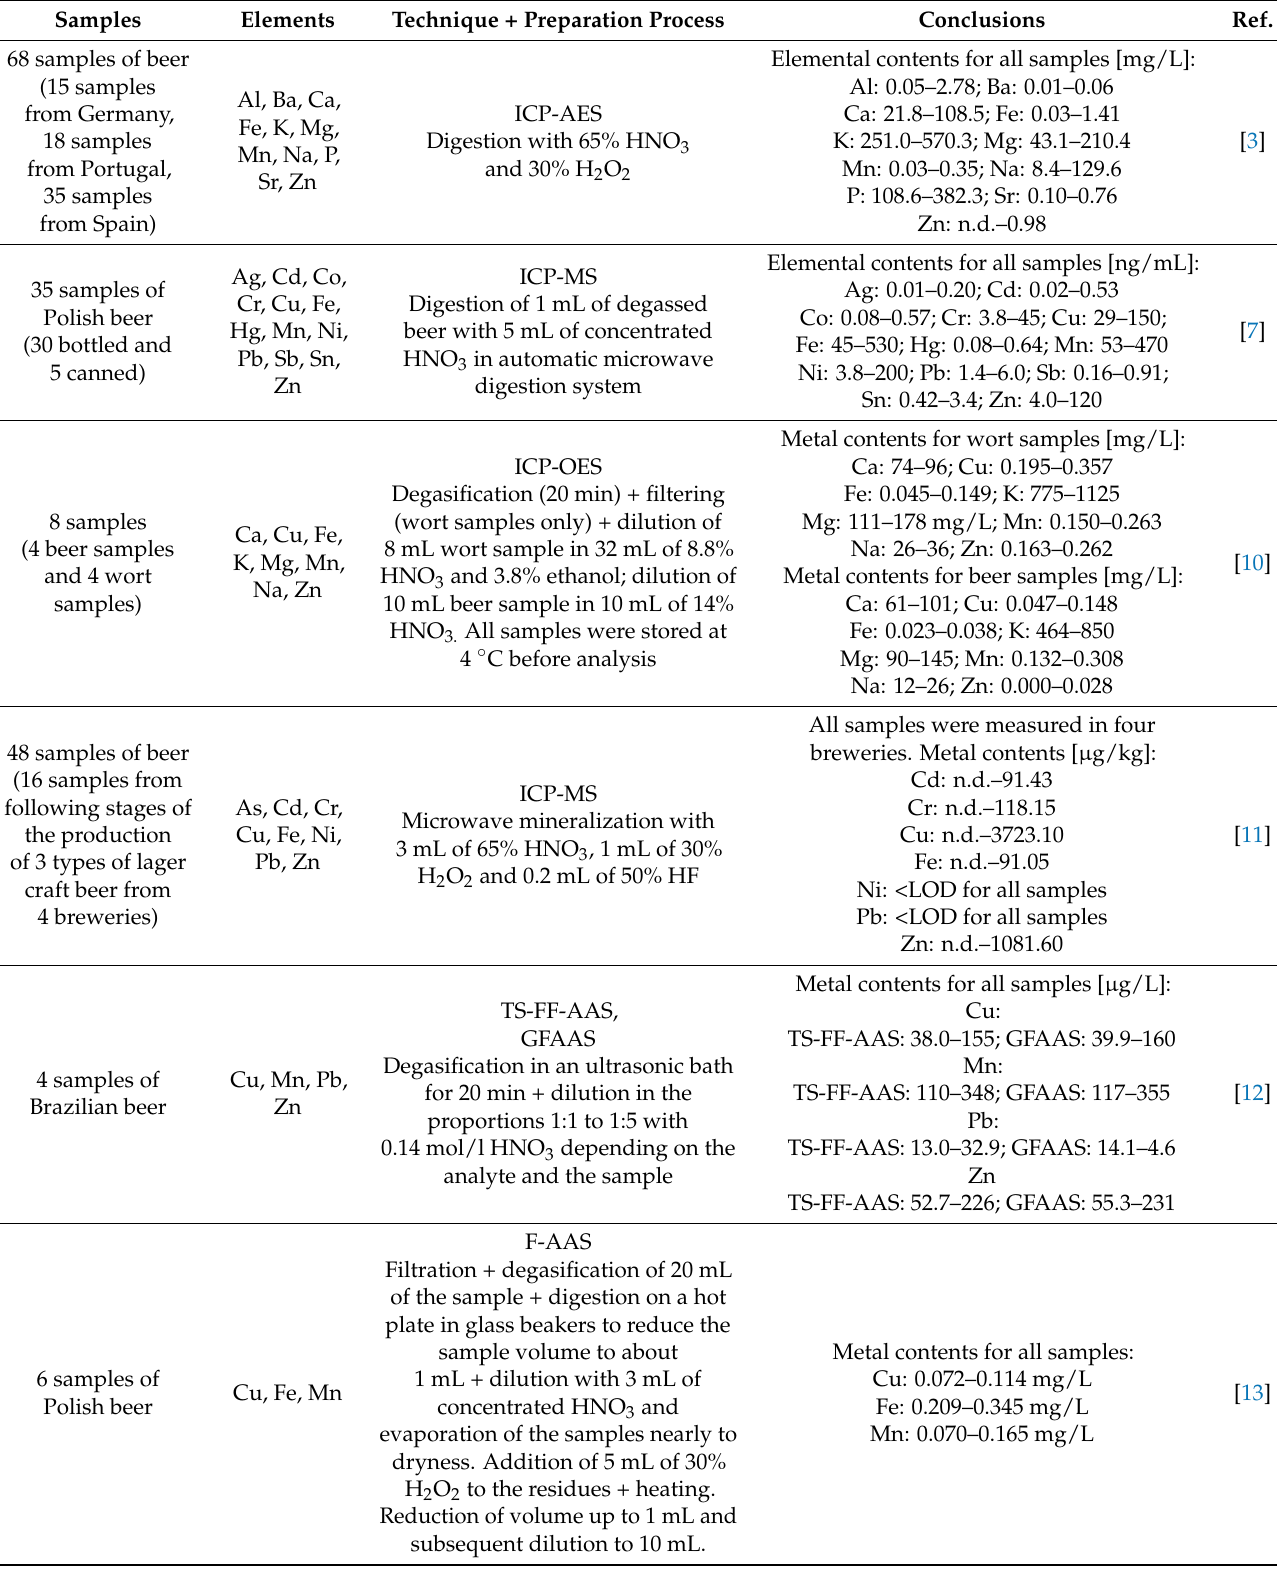
Table 1. A literature review on the content of metals in beer